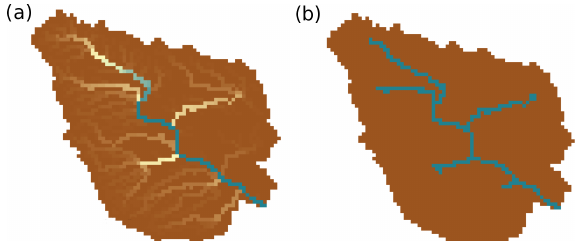
Figure 5. Illustration of the stream network used in this study. (a) Original stream network based on the streamflow routing al- gorithm of mHM; (b) processed stream network that was used in this study. The small tributaries where the runoff rates are below the threshold (0.145m 3 s − 1 ) as shown in panel (a) have been removed to form panel (b)